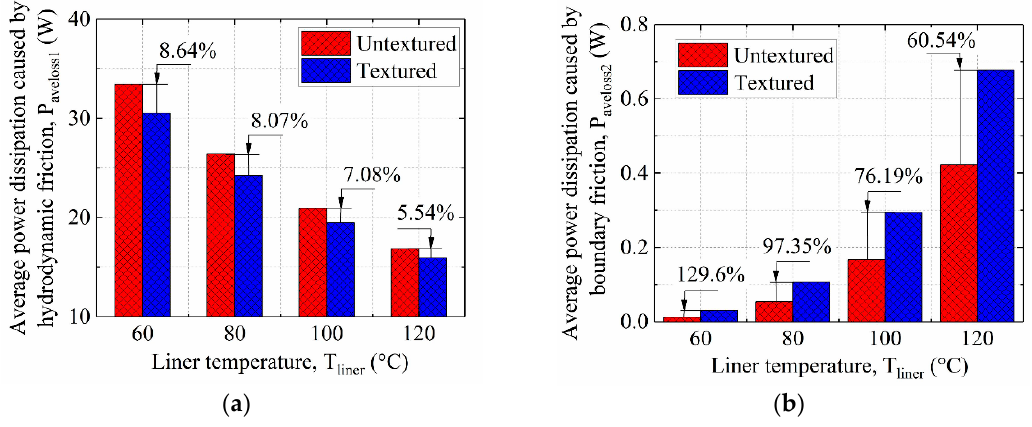
Figure 18. Average power dissipation caused by the hydrodynamic friction and boundary friction for